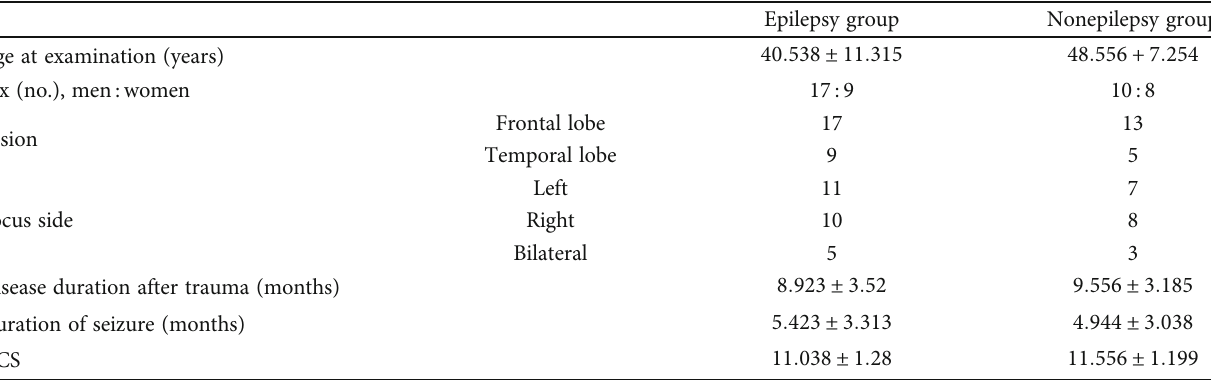
Table 1: Clinical demographics of patients with TLE.